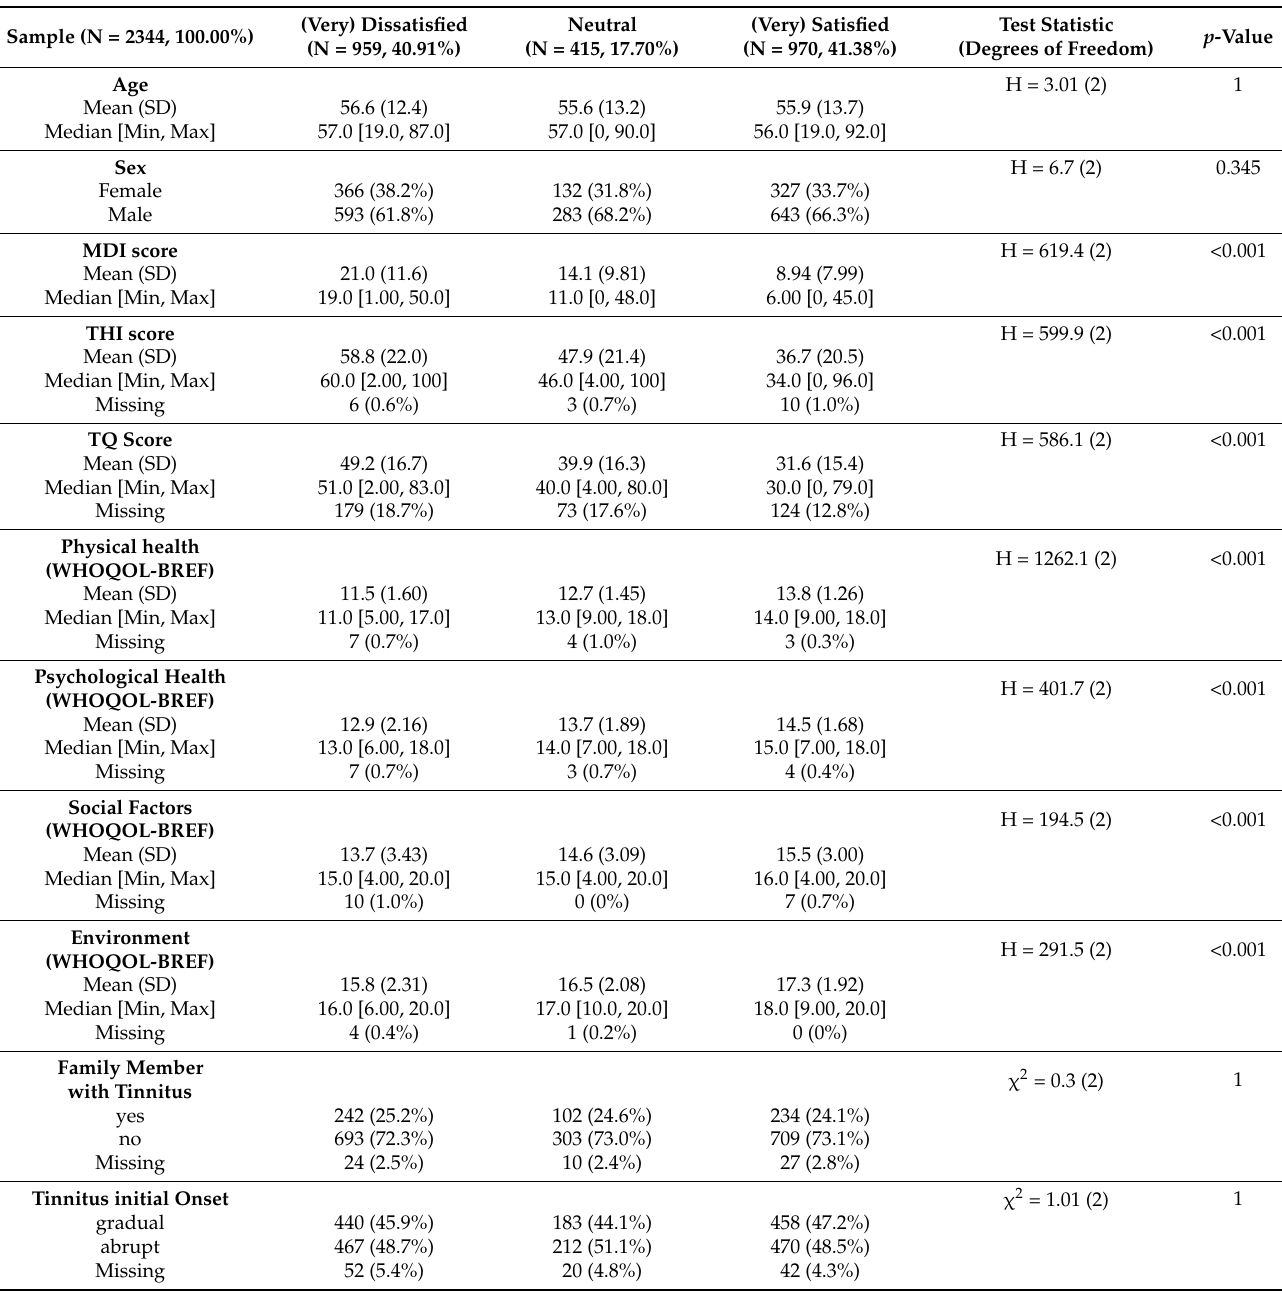
Table 1. Demographics of the study sample ( n = 2344), stratified according to the patient’s reported sleep satisfaction as measured by question 16 of the Bref-WHOQOL (see methods). p -values were corrected for multiple comparisons using the Holm method